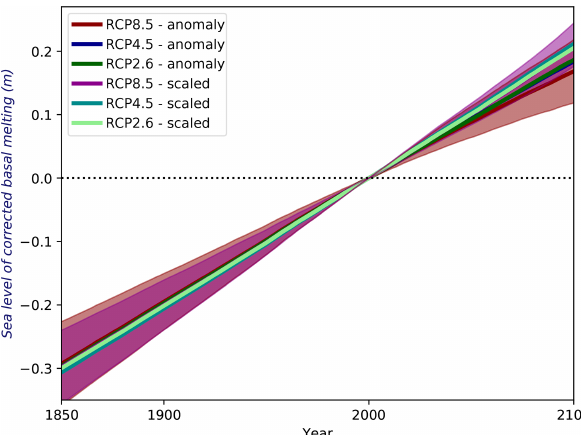
Figure E7. The sea level correction as defined by Eq. (D8) covers the period from 1850 to 2100, where 100% of the additional mass loss contributes immediately to a rising sea level; hence, the ratio p (Eq. D5) equals p = 1 / ( ρA oce ). The correction is computed relative to the simulated sea level for each individual simulation at the year 2000 as in Fig. 8. The corresponding Fig. E5 depicts the case where the correction considers the actual deduced ratio p ( t ).